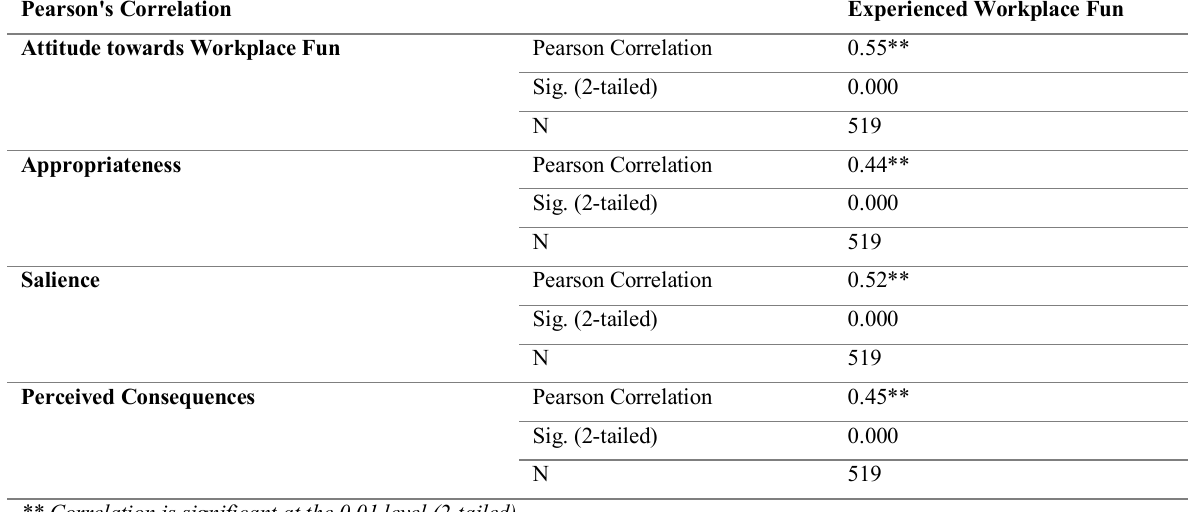
Table 7: Pearson’s correlation conducted to test the relationship between attitude towards workplace fun and experienced Pearson's